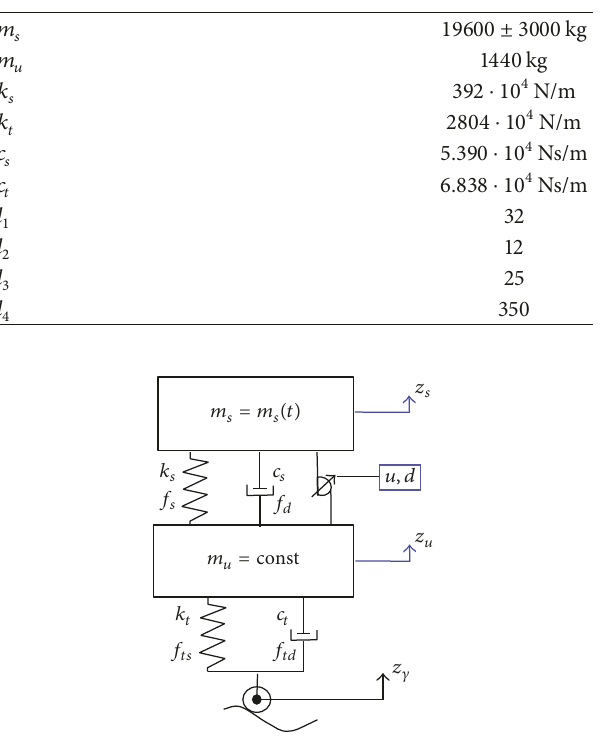
Table 1: Parameters of the suspension system.